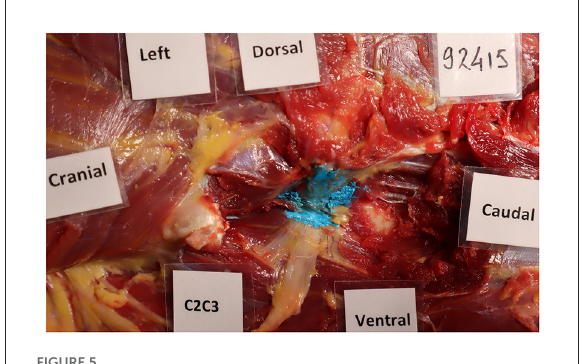
FIGURE5 Presence of latex (blue) within the nerve sheath of